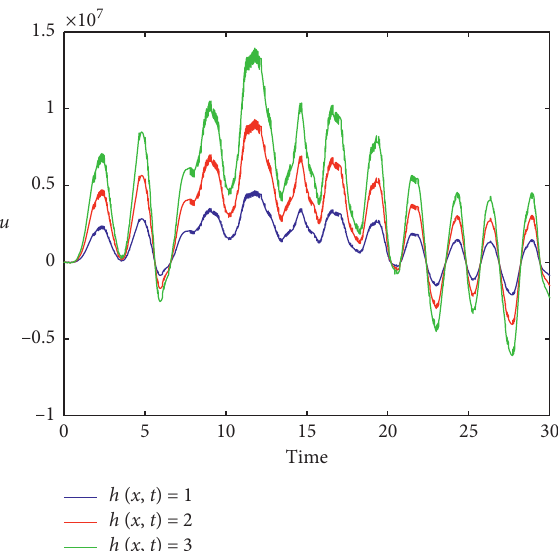
Figure 10: The force variations corresponding to Figure 9.